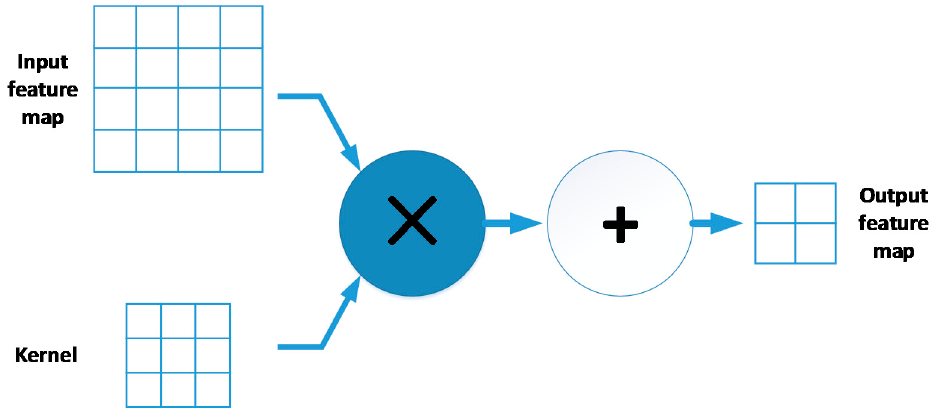
Figure 5. Data flow of the conventional convolution algorithm.